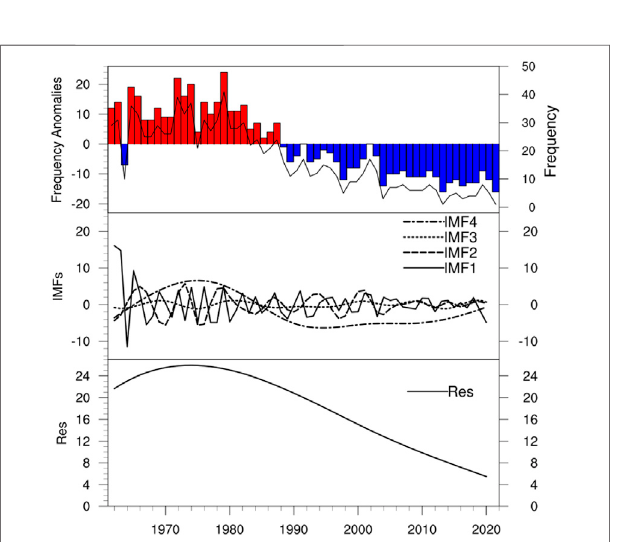
FIGURE 11 | Same as Figure 10 , but for the annual total days of sand- dust